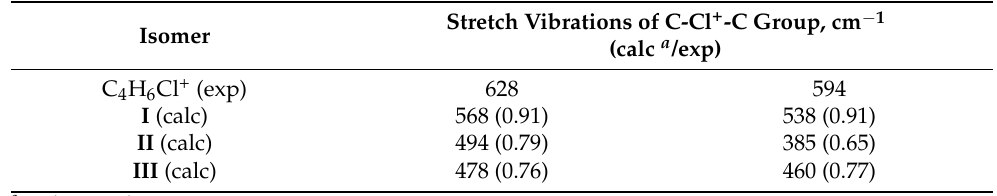
Table 3. A comparison of the stretch vibrations of the C–Cl + –C group of the chloronium cation under study with those calculated for isomers I – III at the B3LYP/6 ‐ 311G++(d,p) level of theory.